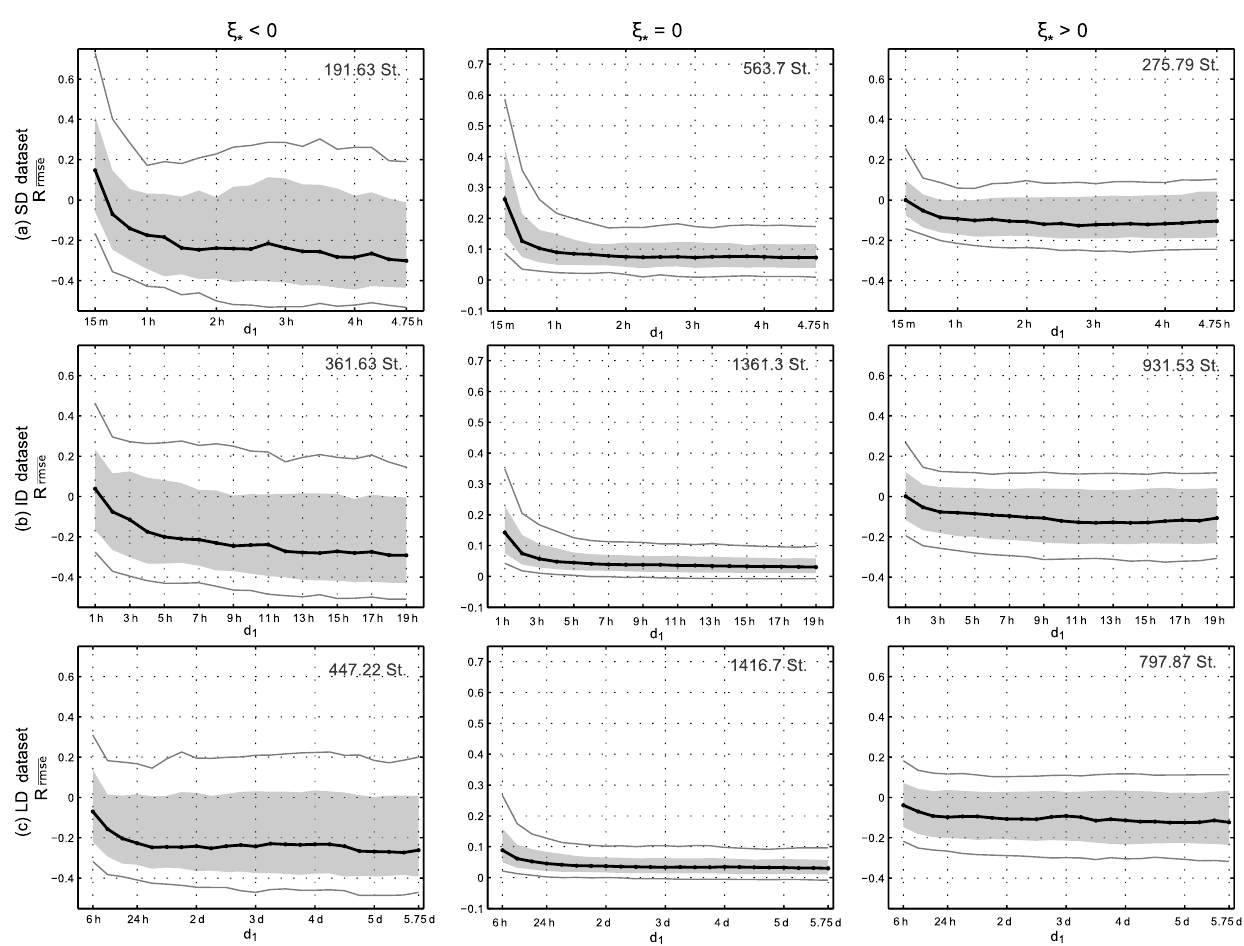
Figure 12. Distribution of the relative total RMSE ratio, R rmse , for ξ ∗ < 0 (first column), ξ ∗ = 0 (second column), and ξ ∗ > 0 (third column) for 6-duration scaling intervals in SD (a) , ID (b) , and LD (c) datasets. The average number of valid SS station over the scaling intervals is indicated in the right-top corner of each